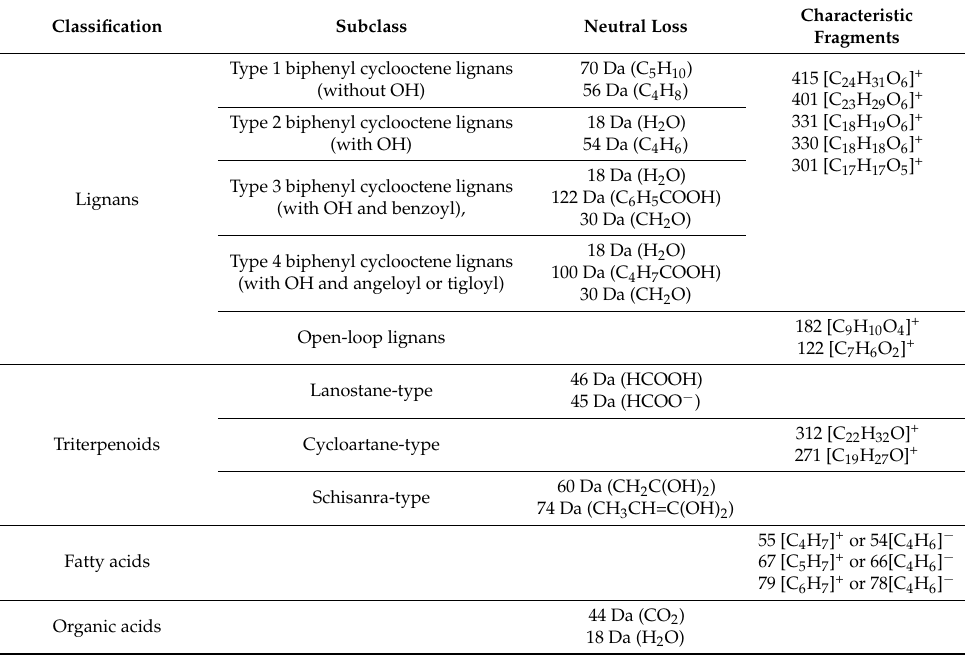
Table 1. Characteristic fragments and neutral loss of different chemical constituents in WWZ extract.